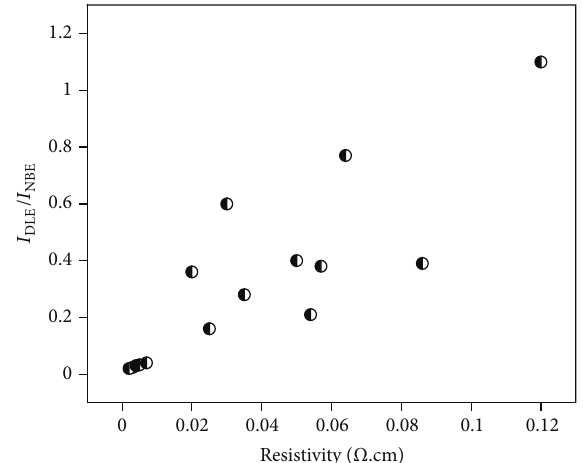
/𝐼 as a function of resistivity for all DLE NBE